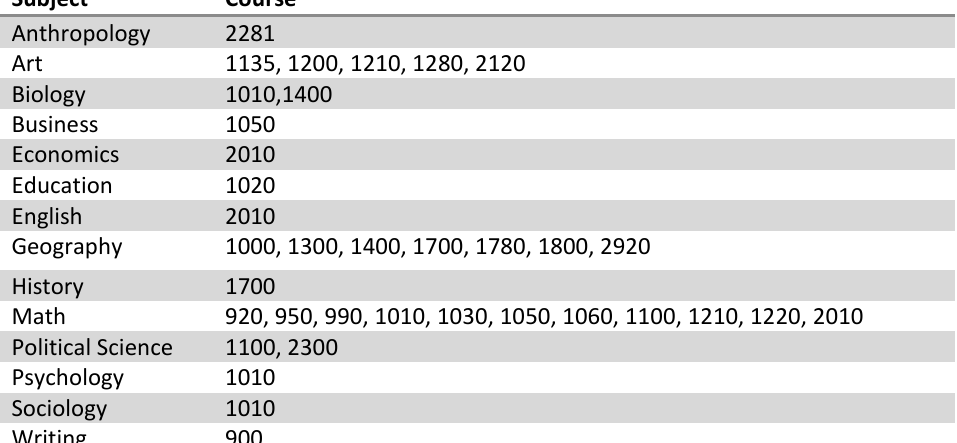
Figure 1. Courses included in the